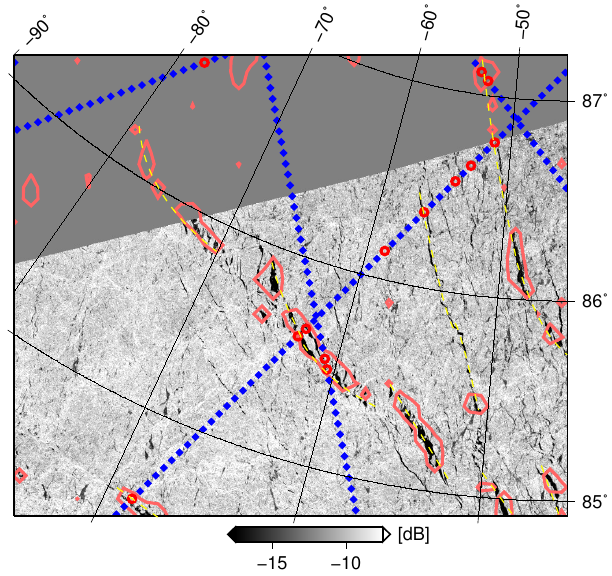
Fig. 6. AMSR-E thin ice concentration isolines (50%, light red), ASAR WSM image (gray), and CryoSat-2 surface classification (red and blue dots) on 23 February 2011. The CryoSat-2 surface classification represents an average of 20 stacked measurements to match the 6.25km spatial resolution of the AMSR-E grid. The hand-drawn splines (thin yellow dashed lines) visualize connected lead structures that are simultaneously detected in the AMSR-E, ASAR and CryoSat-2